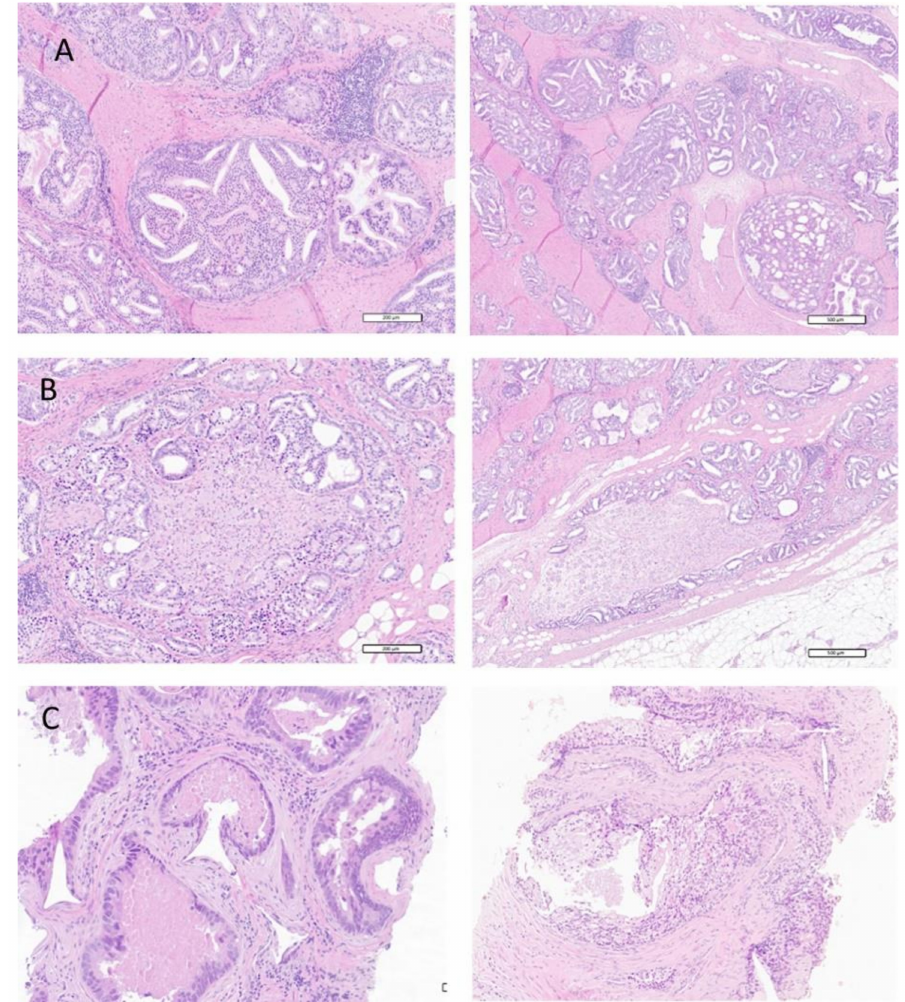
Figure 1. Selected histological images of patients with cribriform or intraductal carcinoma. ( A ) Histo- logical images of the most representative cases of prostate cancer with a cribriform pattern: medium and large glands with irregular contours, jagged edges, with irregularly and fissured lumen separated into compartments by cell bridges without interposed stroma. ( B ) Prostate cancer with cribriform pat- tern and neuroinvasion of a ganglion: perineural invasion defined as cancer cell invasion around and through nerves. ( C ) Intraductal carcinoma of the prostate: large glands, comedonecrosis character- ized by intraluminal necrotic cells, significant nuclear atypia including enlargement, anisonucleosis, prominent nucleoli and preservation of basal cells around these glands. Scale bar = 200 µ